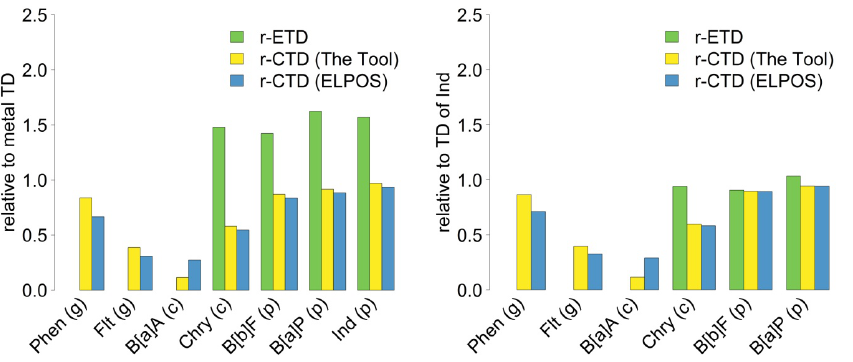
Figure 5. Comparison of relative ETDs and CTDs of PAHs at 4° C (( left ): relative to metals (ETD) and particles (CTD); ( right ): relative to